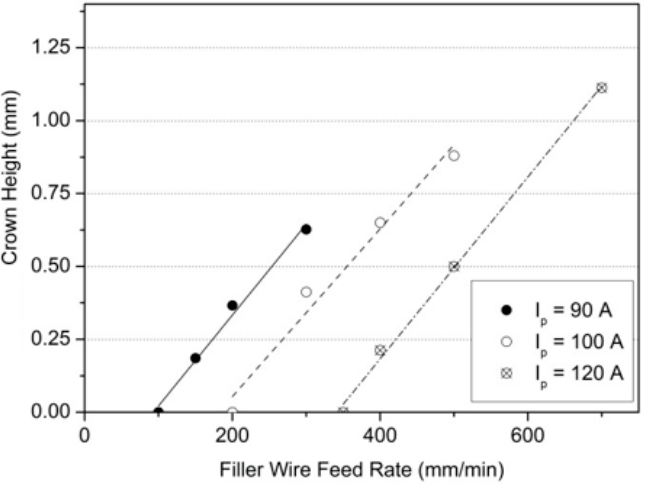
Figure 3. Obtained crown height for different filler wire feed rates for multiple current levels.